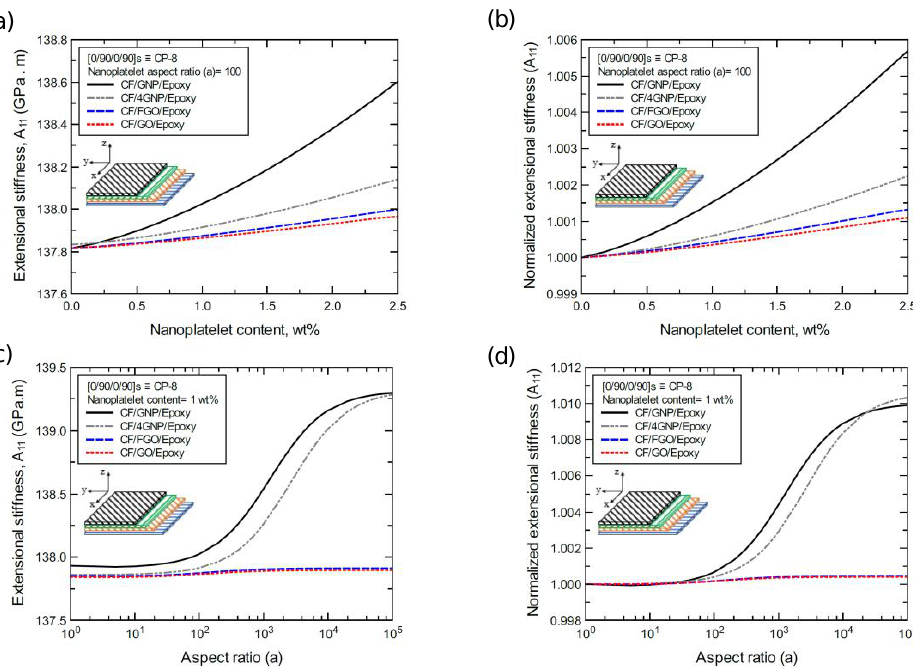
Figure 12. Comparison of the predicted extensional stiffness (A 11 ) for a [0/90/0/90]s (CP-8)-laminated composite plate based on the nanoplatelet type, content, and aspect ratio; ( a ) predicted A 11 for various nanoplatelet contents at 100 aspect ratio, and the normalized response is shown in ( b ); ( c ) predicted A 11 for various aspect ratio values at 1.0 wt% nanoplatelet content, and the normalized response is shown in ( d ). The volume fraction of CF is 56%.